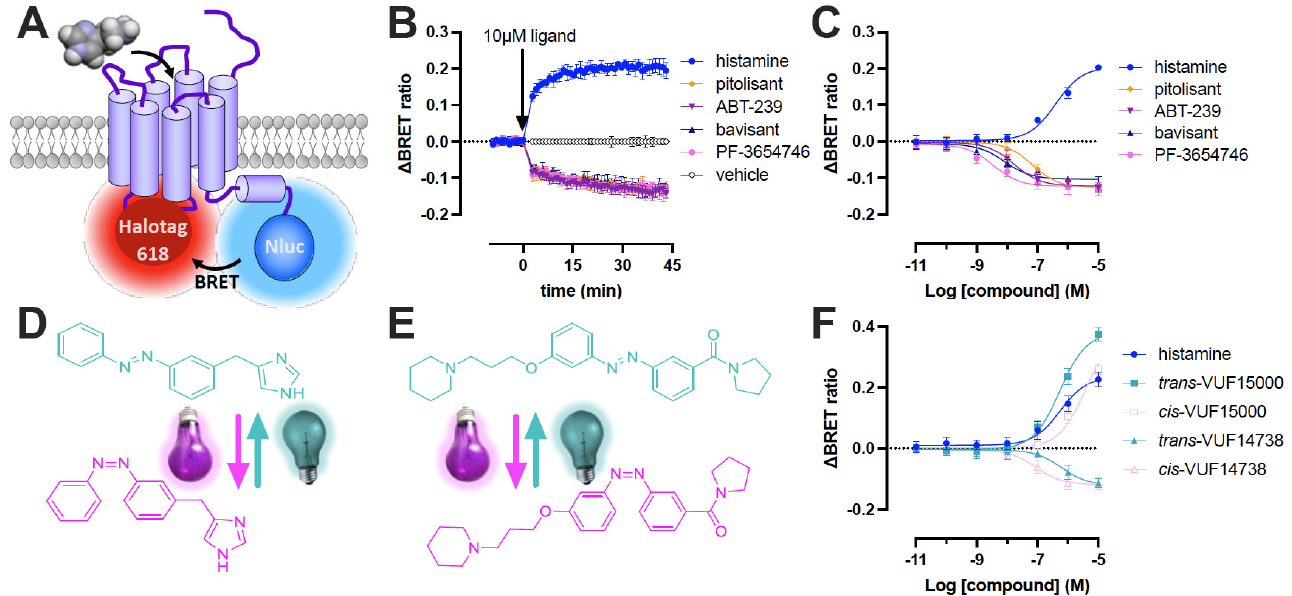
Figure 1. Ligand-induced changes in Δ icl3-H 3 R Nluc/Halo(618) biosensor conformation detected by BRET in intact HEK293A cells. ( A ) Scheme of H 3 R biosensor configuration with the self-labeling HaloTag protein inserted in the truncated IL3 between Thr 229 and Phe 348 and Nluc fused to the C-terminal tail as the BRET acceptor and donor, respectively. ( B ) Conformational changes in Δ icl3-H 3 R Nluc/Halo(618) upon stimulation with 10 μ M H 3 R ligands measured as Δ BRET ratio in time. ( C ) Concentration-response curves measured after 30 min stimulation of the H 3 R biosensor with H 3 R ligands. Data are displayed as mean ± SD from 4 independent experiments performed in duplicate. (D-E) the photo-switchable agonist VUF15000 ( D ) and inverse agonist VUF14738 ( E ) switch from trans (cyan) to cis (magenta) upon illumination with 360 nm and from cis to trans by illumination with 430 nm. ( F ) Concentration-response curves measured after 20 min stimulation of the H 3 R biosensor with dark ( trans ) or pre-illuminated ( cis ) photo-switchable VUF15000 and VUF14738. Data are displayed as the mean ± SD from 3 independent experiments performed in duplicate.